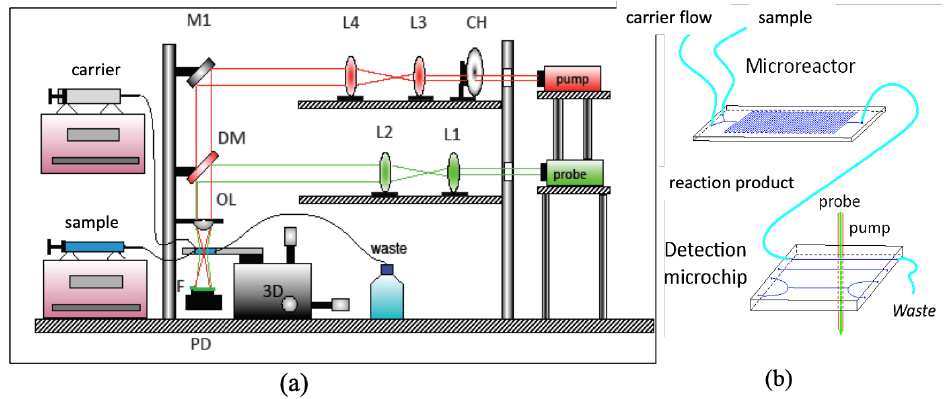
Figure 1. Schematic diagram of a laser-excited TLM ( a ) coupled with a microfluidic system ( b ).